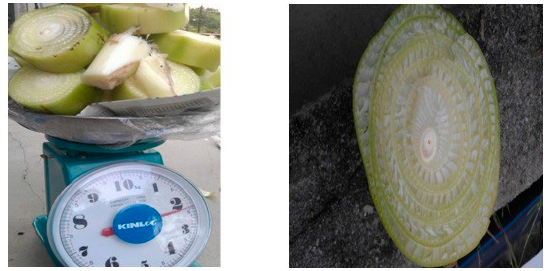
Figure 2. Collected banana stem.